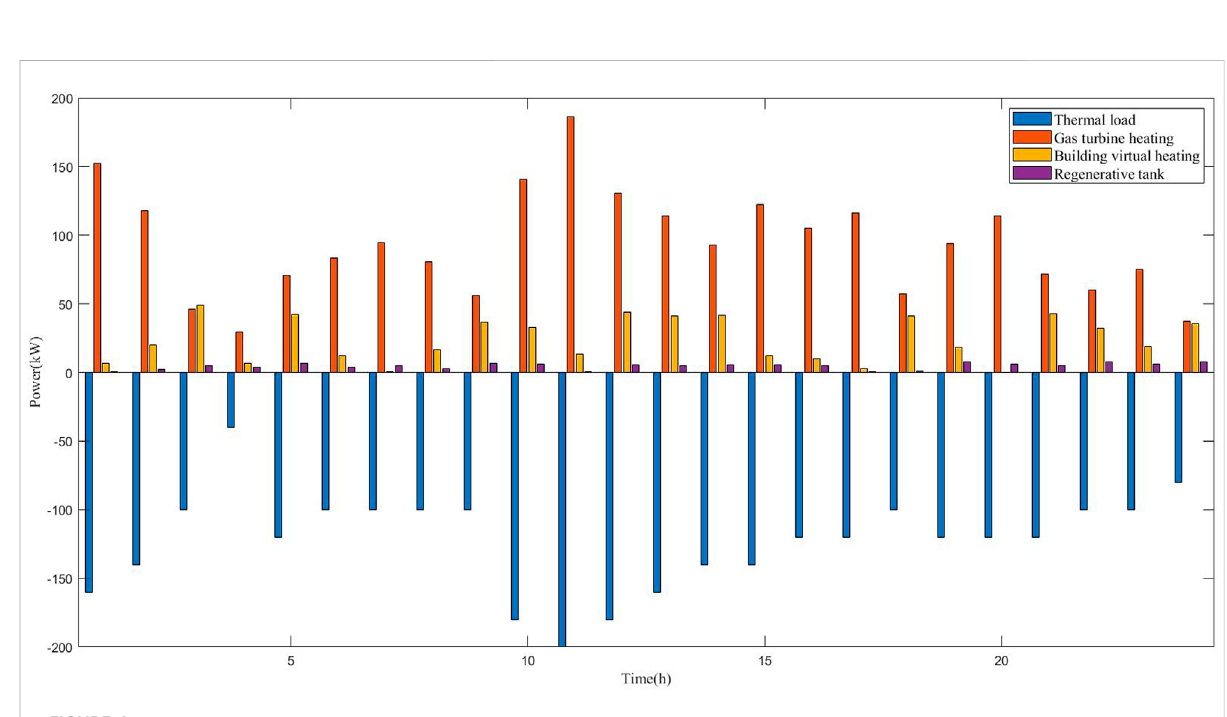
FIGURE 4 Optimization results of the heat load under Case